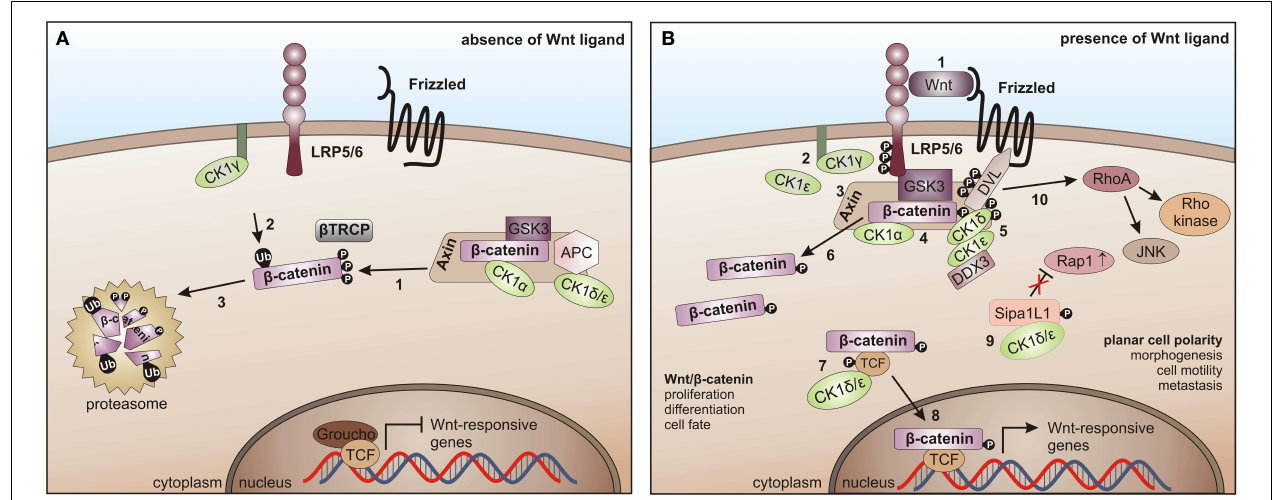
change in the β -catenin destruction complex and initiate the dissociation of various components (6). CK1 ε cooperates with DDX3 in phosphorylating DVL (7). Also,TCF3 can be phosphorylated by CK1 δ and ε thereby increasing its binding to β -catenin followed by the nuclear translocation ofTCF3/ β - catenin (8).The non-canonicalWnt pathway is positively regulated by CK1 δ - and ε -dependent release of Rap1 from Sipa1L1 inhibition (9).The Rho/JNK signaling cascade is activated after phosphorylation of DVL (10) [adapted from Cheong andVirshup